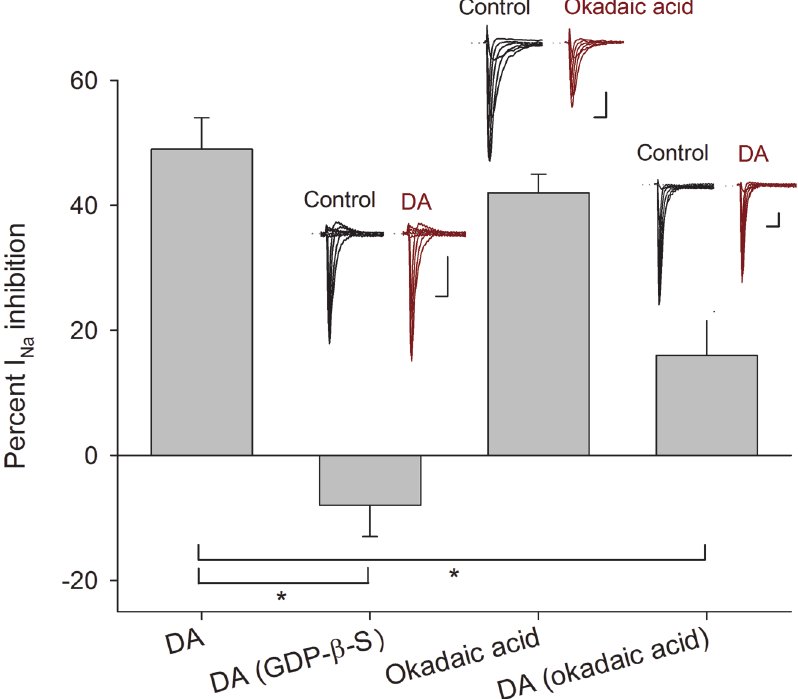
Fig 3. Intracellular mechanism inherent to D1- and D2-like receptors. Bars indicate the percent I Na inhibition produced by 100 μ M DA and compared with its effect when 500 μ M GDP- β -S ( P < 0.001) were added intracellularly. The perfusion of 100 nM okadaic acid decreased the I Na amplitude in a similar percentage as 100 μ M DA ( P = 0.3 unpaired t-test ). While 100 nM okadaic acid added intracellularly occluded the DA action ( P = 0.01). Insets above bars show representative recordings in control conditions and after drug application. Asterisks denote a significant difference ( P < 0.05 unpaired t-test ). Calibration bars are 1 ms and 0.5 nA for all